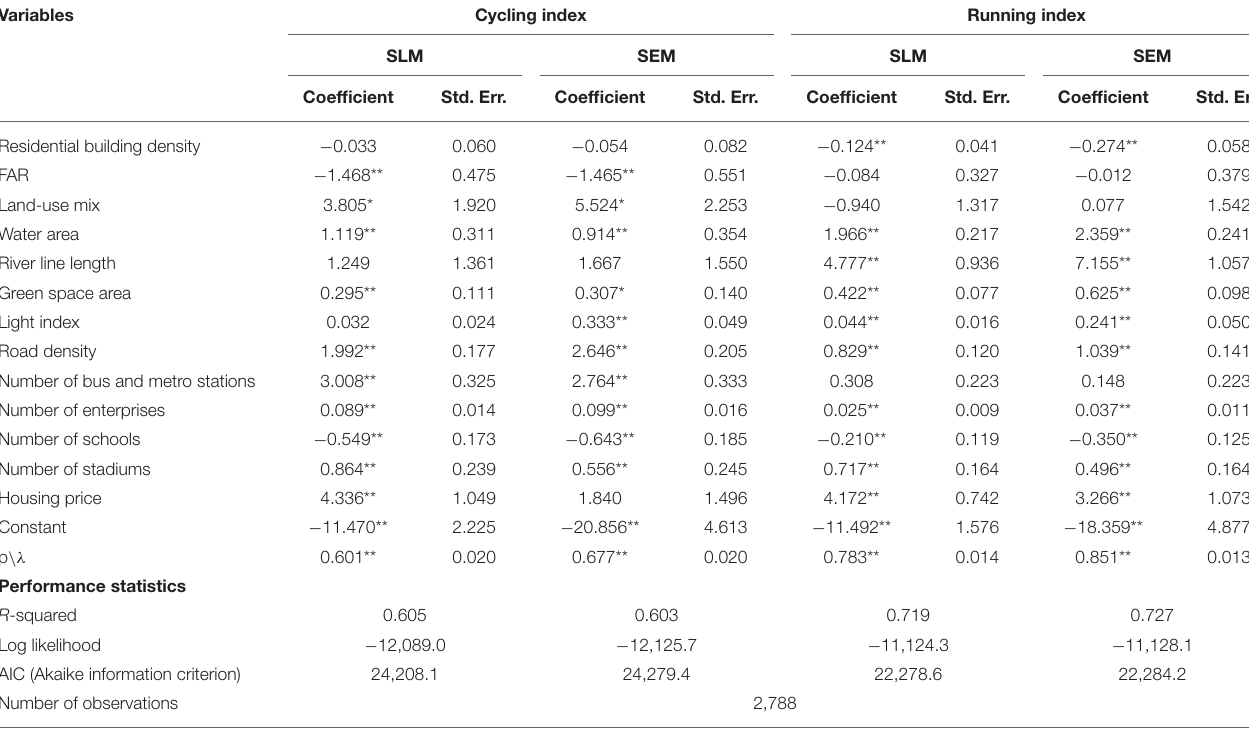
TABLE 3 | Spatial modeling results.